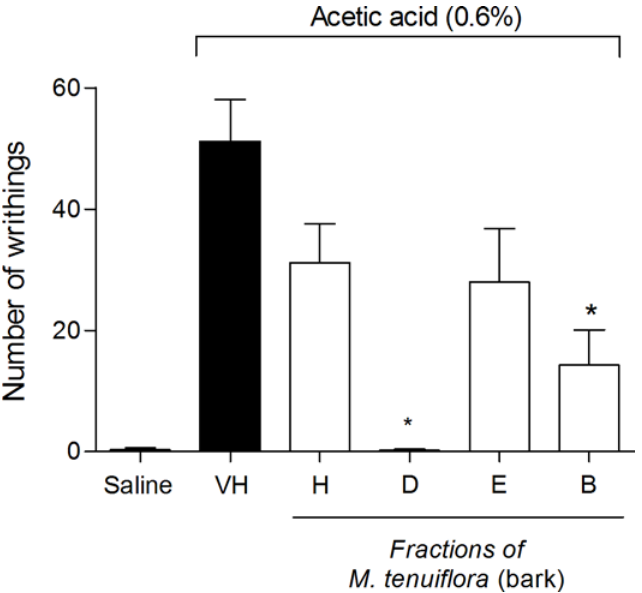
Fig 11. Effect of pretreatment of the mice with the hexane (H), DCM (D), ETOAc (E) and BuOH (B) (100 mg/kg) soluble fractions of the M . tenuiflora extract on acetic acid (0.6%)-induced writhing. VH is the vehicle group (negative control). The results are presented as the mean ± S.D. (n = 8). Statistical significance was calculated by ANOVA followed by Bonferroni's test. * P < 0.05 compared to the vehicle-negative control treated